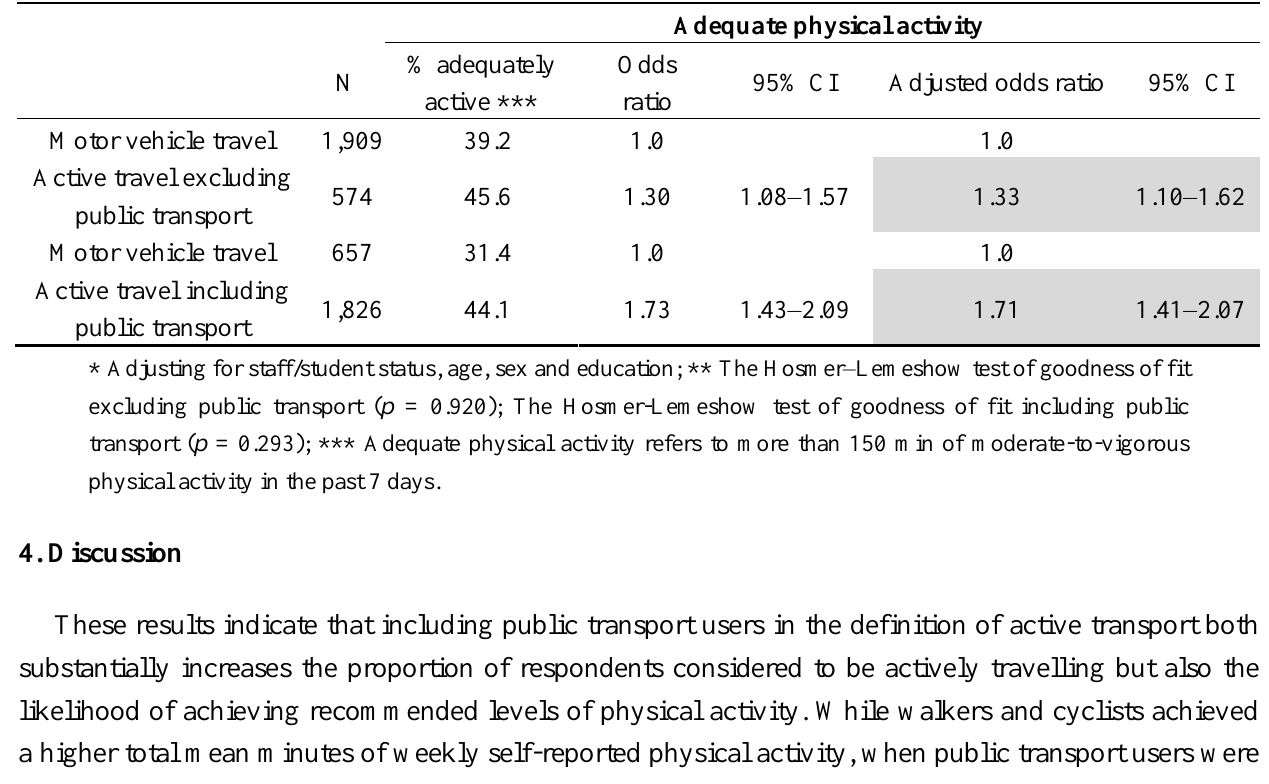
Table 5. Adjusted model * of odds of being adequately physically active and travel mode for walking and cycling only compared with motor vehicle travel, and public transport combined with walking and cycling